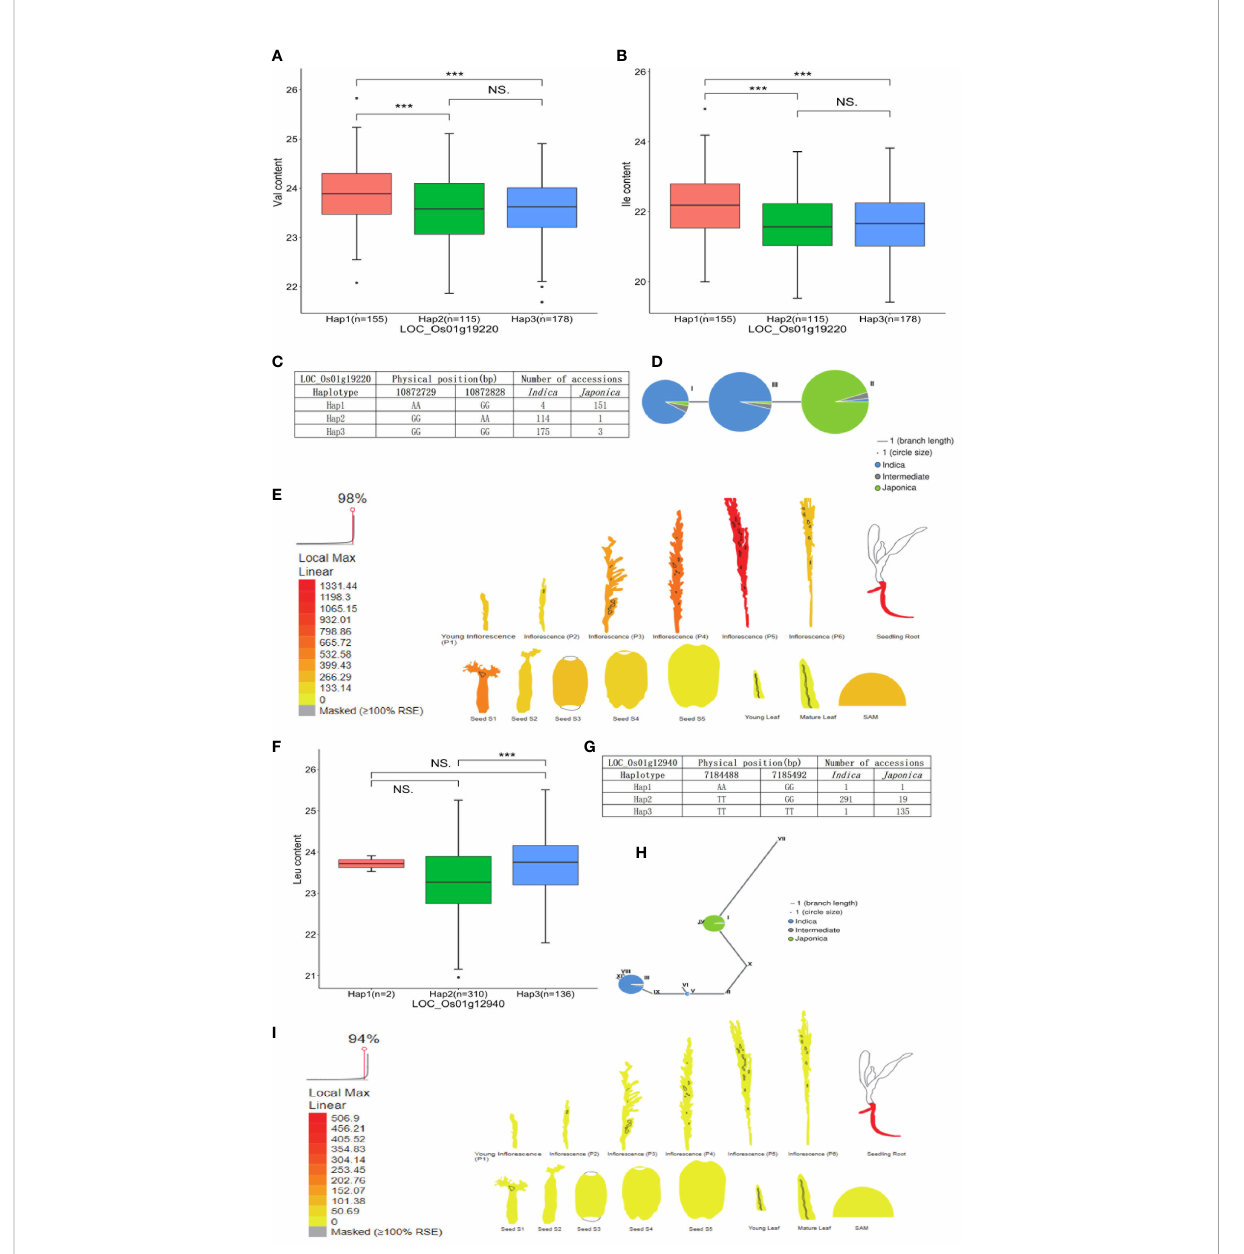
FIGURE 6 Analyses of Val and Ile level associated gene LOC_Os01g19220 and Leu level associated gene LOC_Os01g12940. (A) Signi fi cant tests between three haplotypes of LOC_Os01g19220 and Val contents. (B) Signi fi cant tests between three haplotypes of LOC_Os01g19220 and Ile contents. (C) Three haplotypes of LOC_Os01g19220 and their distribution in indica and japonica accessions. (D) Haplotype network of LOC_Os01g19220. (E) Expression pro fi le of LOC_Os01g19220 based on ePlant transcriptome analysis in rice; expression strength coded by color from yellow (low) to red (high). (F) Signi fi cant tests between three haplotypes of LOC_Os01g12940 and Leu contents. (G) Three haplotypes of LOC_Os01g12940 and their distribution in indica and japonica accessions. (H) Haplotype network of LOC_Os01g12940. (I) Expression pro fi le of LOC_Os01g12940 based on ePlant transcriptome analysis in rice, expression strength coded by color from yellow (low) to red (high). *** and NS indicate statistical signi fi cance at the 0.1% probability level and no signi fi cant difference,